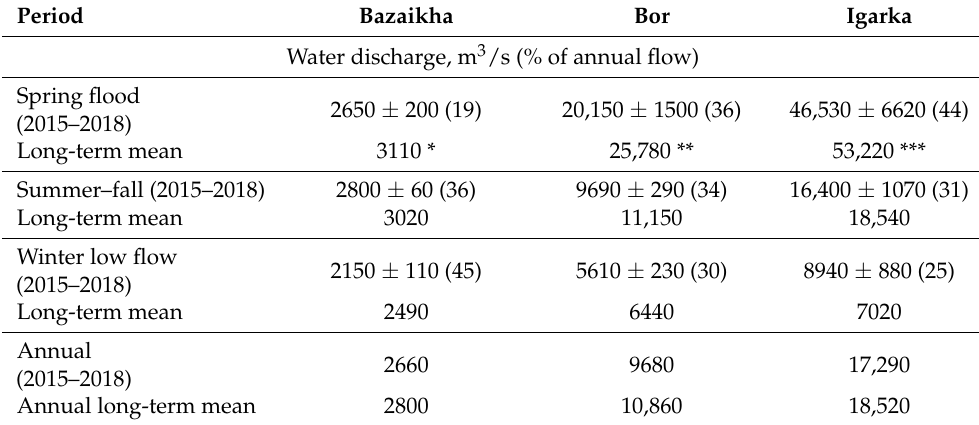
Table 2. Seasonal and annual discharge of the Yenisei River for 2015 to 2018 and long-term mean values at the Roshydromet gauging stations: Krasnoyarsk (Bazaikha, 56.0 ◦ N, 2468 km to the outlet), Bor (Podkamennaya Tunguska, 61.5 ◦ N, 1568 km) and Igarka (67.4 ◦ N, 697